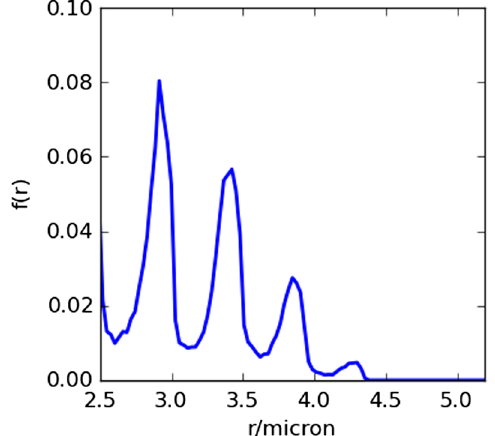
FIG. 5. Number of particles f ð r Þ as a function of the radial distance r from the center of the droplet, integrated over all angles for a droplet with radius R ¼ 100 nm illuminated by a laser at intensity I ¼ 10 20 W = cm 2 . The particles are probed at a time corresponding to Fig. 1c. FIG. 6. Geometry of bunch deflection due to space